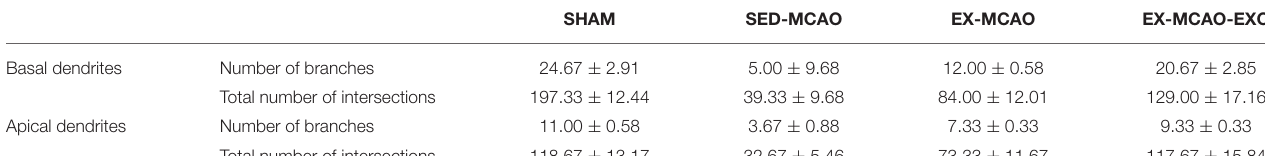
TABLE 1 | Characteristics of basal and apical dendrites in each group.